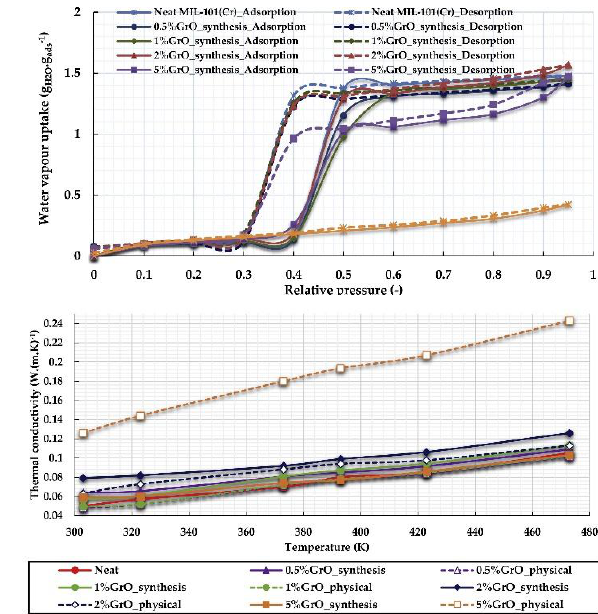
Figure 13. ( a ) Water adsorption isotherms and ( b ) Thermal conductivity of MIL-101(Cr) and Matérial Institute Lavoisier (MIL)/graphene oxide (GO) composites. Reproduced with permission from [96]. Elsevier, 2017.